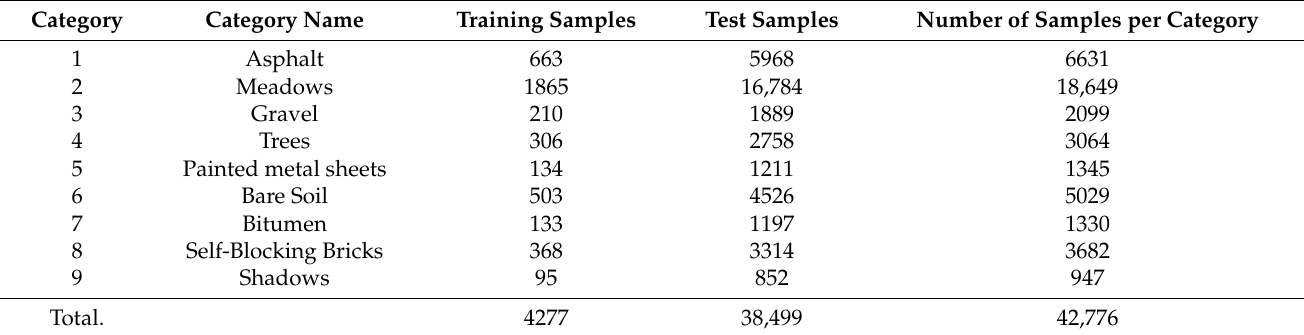
Table 3. Training and Test Samples for UP.